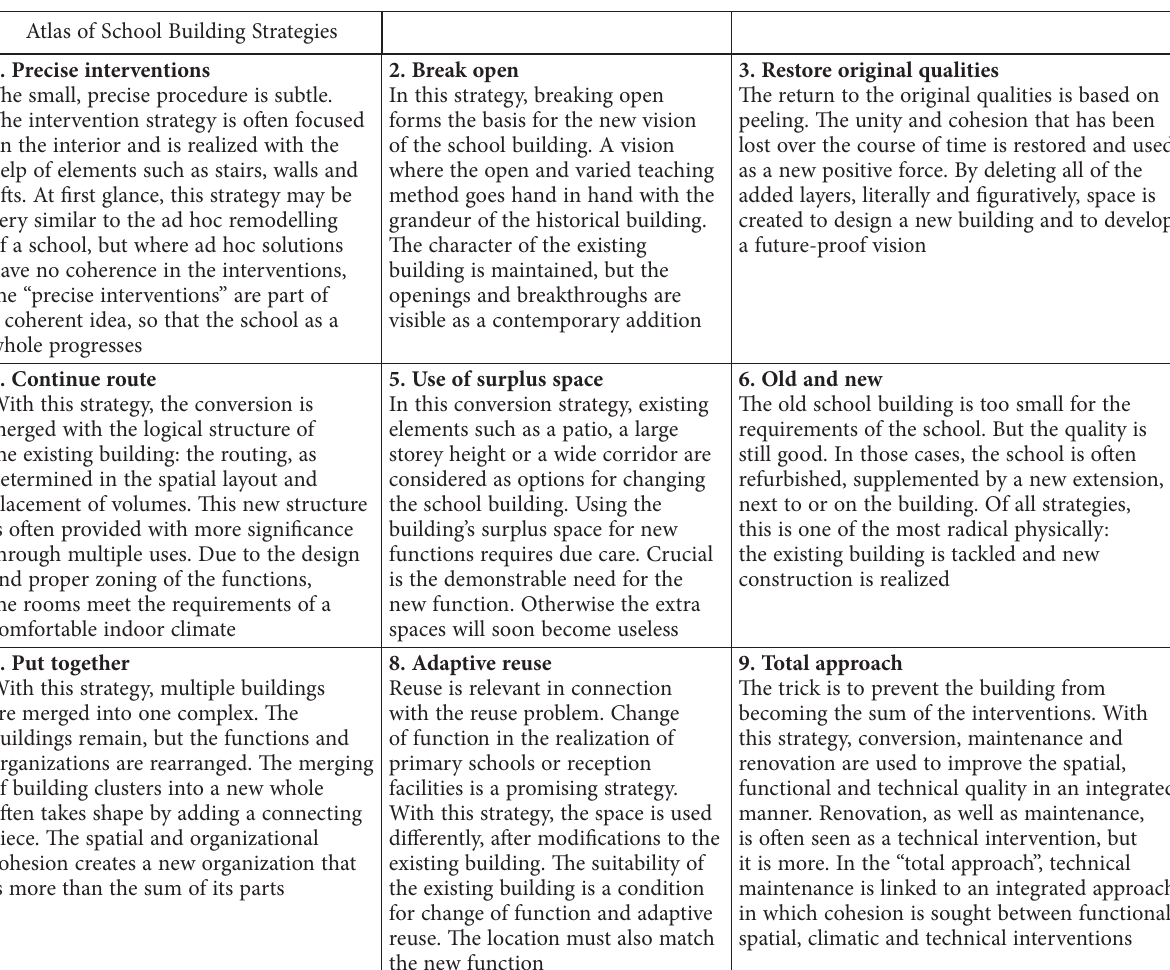
Table 1. Table of strategies in the Atlas of School Building . Explanation of the nine conversion strategies (source: